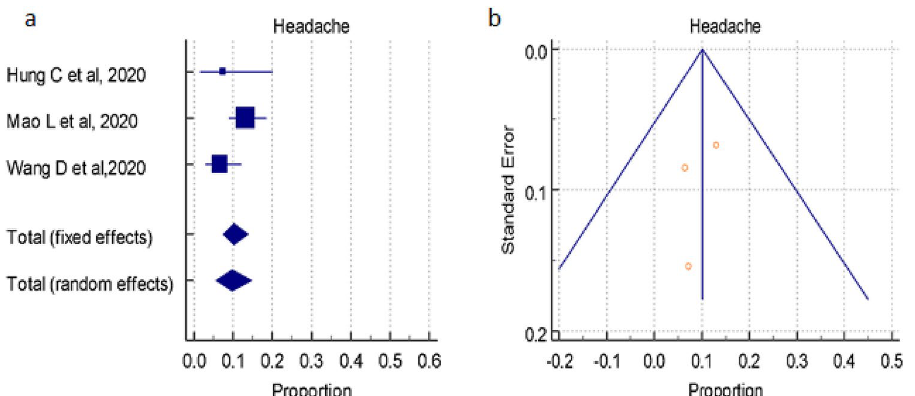
Figure 9. ( a ) Forest plot showed pooled prevalence of Headache among patients with COVID-19. ( b ) Funnel plot showed publication bias among studies evaluating neurological complications of